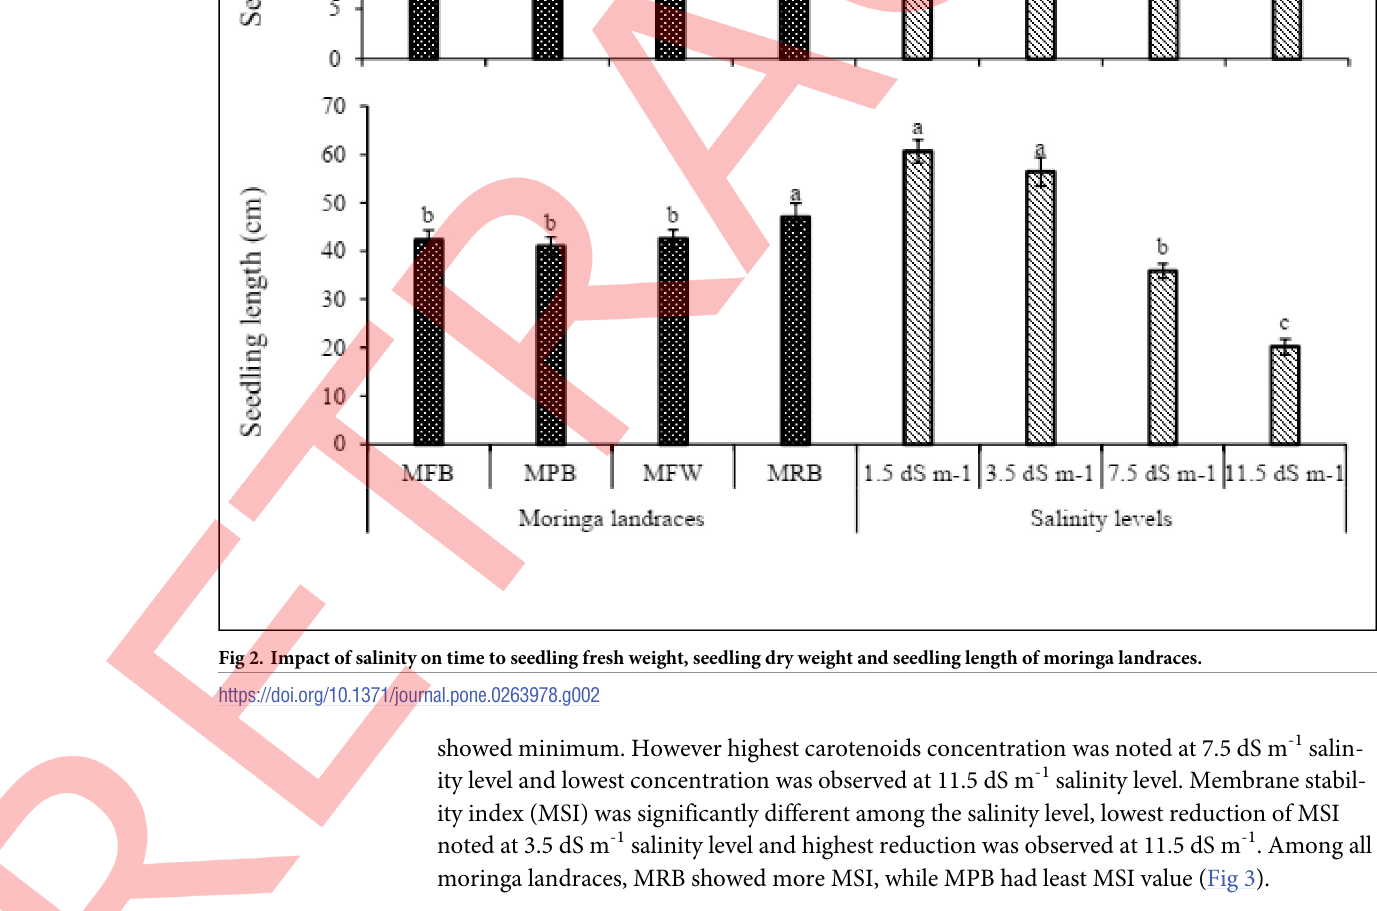
PLOS ONE | https://doi.org/10.1371/journal.pone.0263978 February 22,